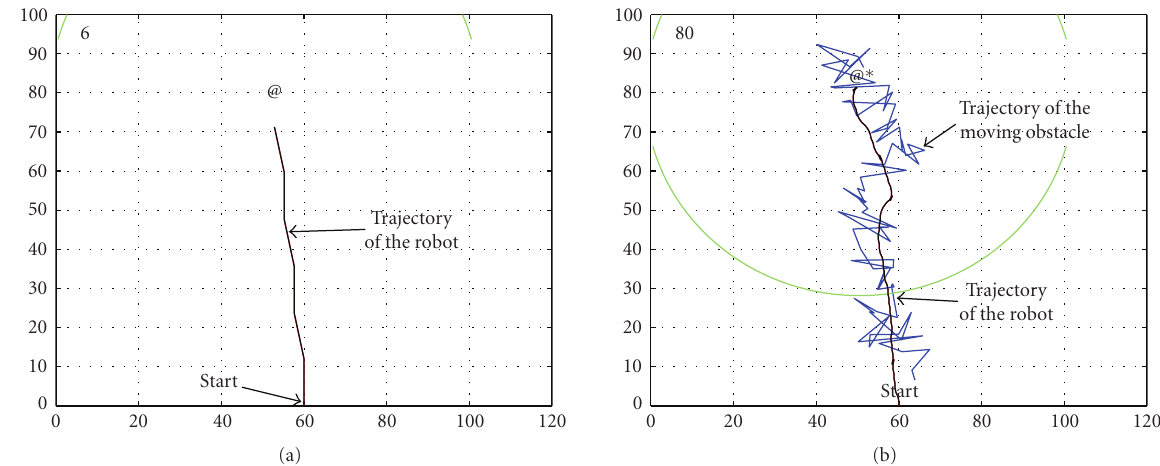
Figure 7: (a) shows the robot motion with nonholonomic constraints, no obstacle. (b) shows the robot motion with nonholonomic constraints, with a random moving obstacle, note that to fully test our algorithm, we keep the moving obstacle activated for each step.